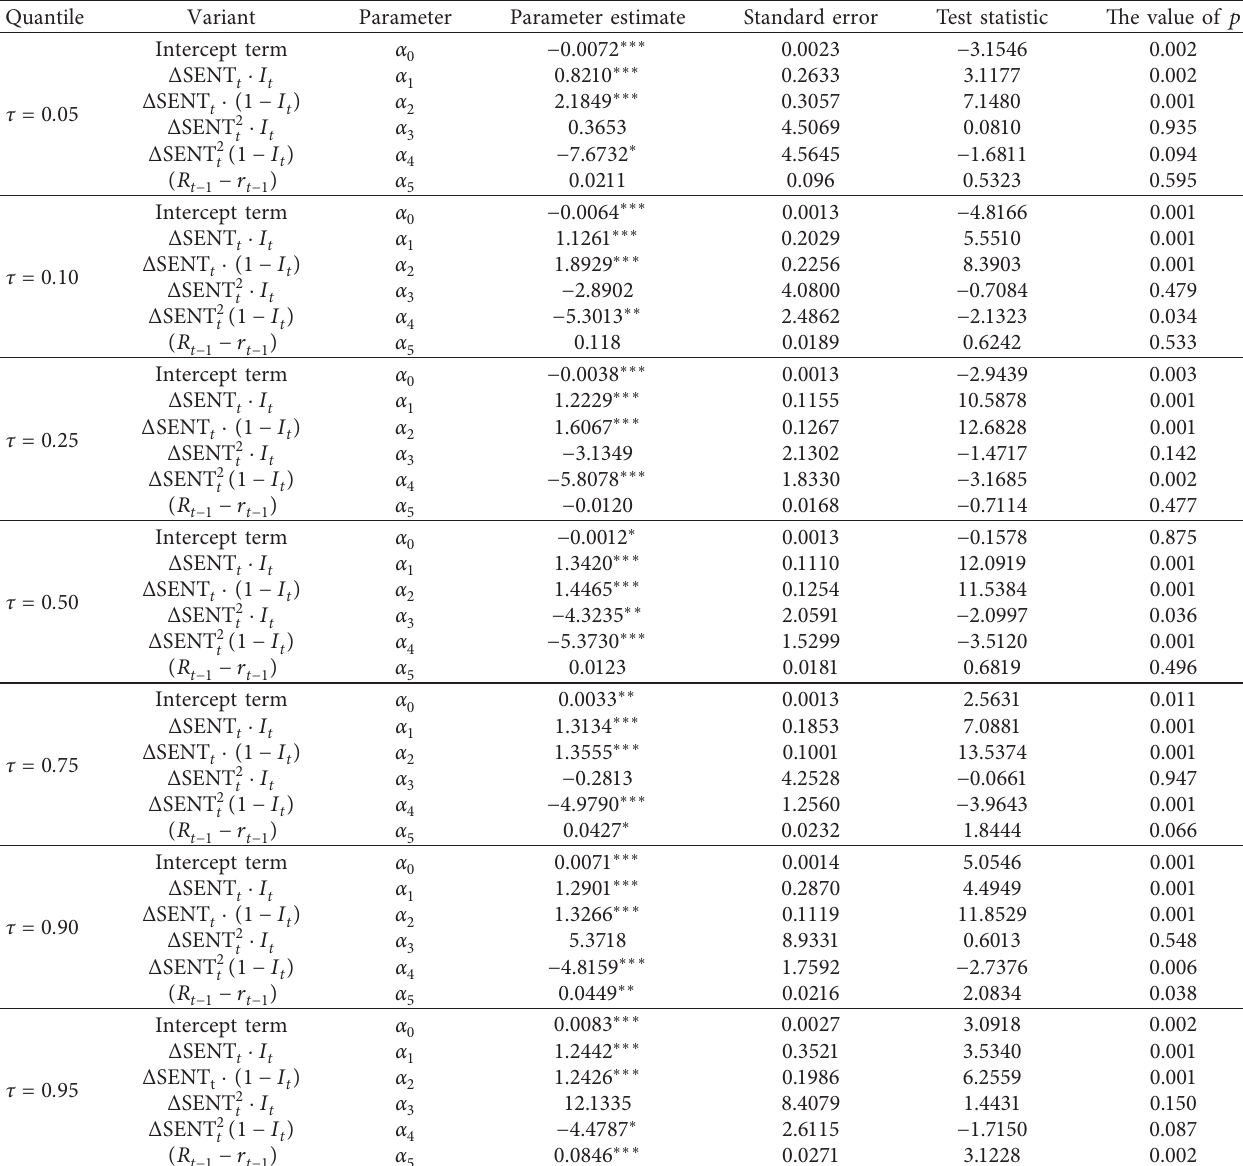
Table 4: Linear quantile regression